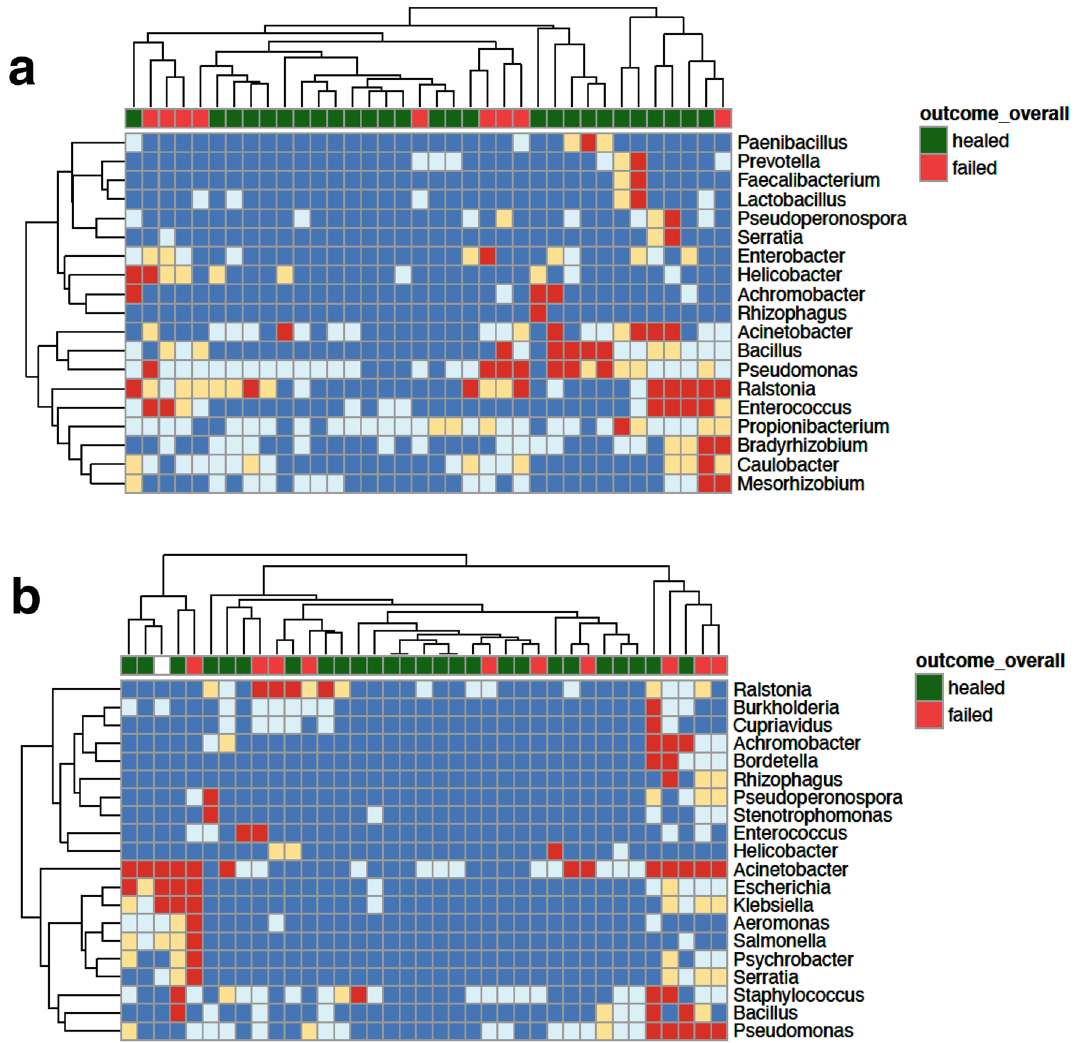
sequence data, is binned and shown as follows: Only microbial genera for which at least one analyzed specimen demonstrated a relative abundance for that genus of > 1E−5 are shown. Abundance values were binned on a log scale. dark blue: < 1E−7, light blue: ≥ 1E−7 & < 1E−6, yellow: ≥ 1E−6 & < 1E−5, red: ≥ 1E−5. Wound outcome is annotated along the top of the heatmap, with green indicating successful healing; red indicating failed; white indicating outcome not